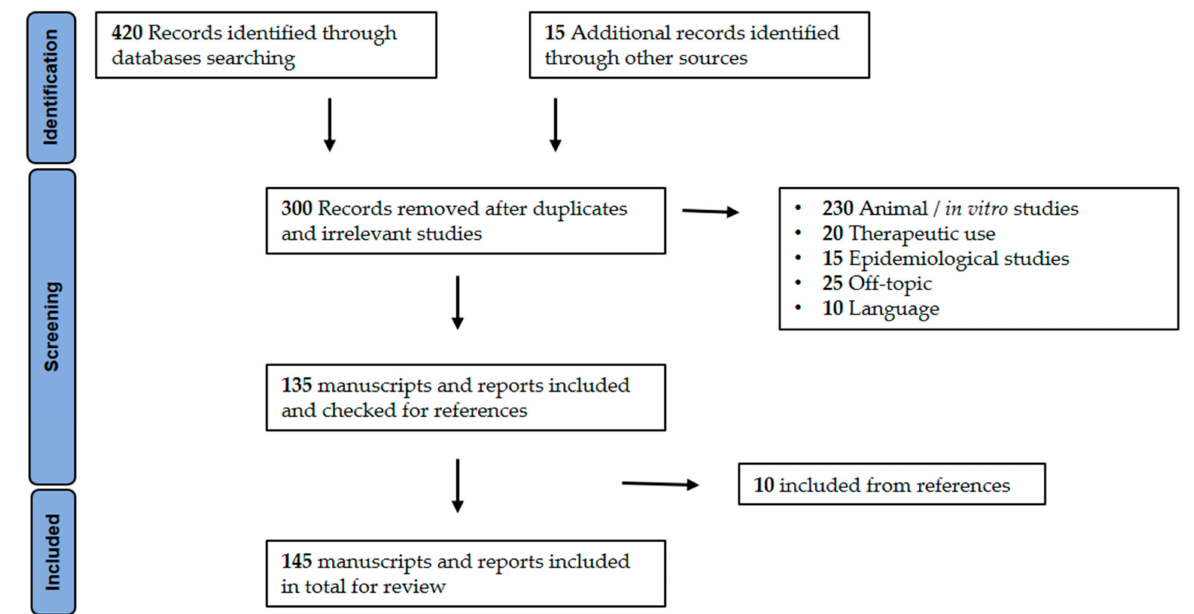
Figure 1. Flow diagram of study identification, screening, and selection. 3. Endogenous Cannabinoids and Receptors N -arachidonoyl-ethanolamine (AEA) and 2-arachidonoyl glycerol (2-AG) are the two most studied endocannabinoids (eCBs), although other eCBs also exist, including 2-arachidonyl glycerol ether (Noladin ether), O-arachidonoyl ethanolamine (virodhamine), N-arachidonoyl glycine, and N-arachidonoyl dopamine (NADA) [22–25] (Figure 2).